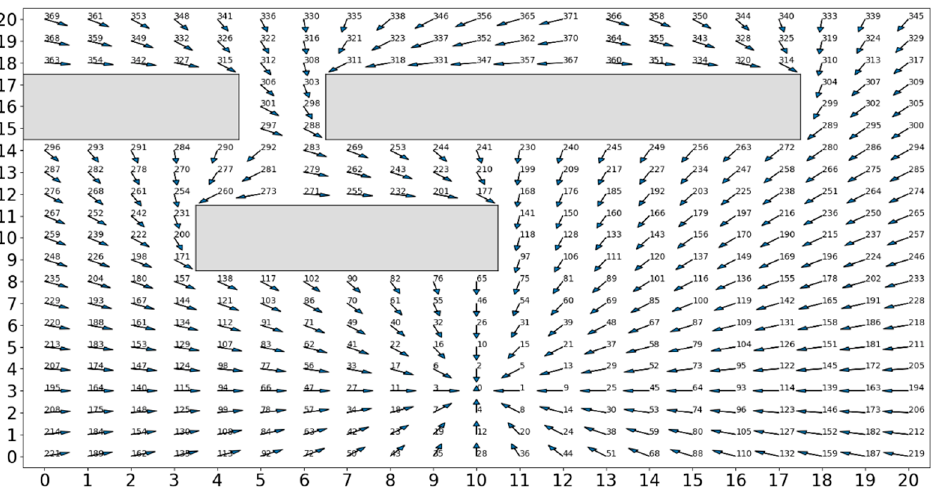
Figure 8. The computation order (each number before arrow) for the cell propagation.